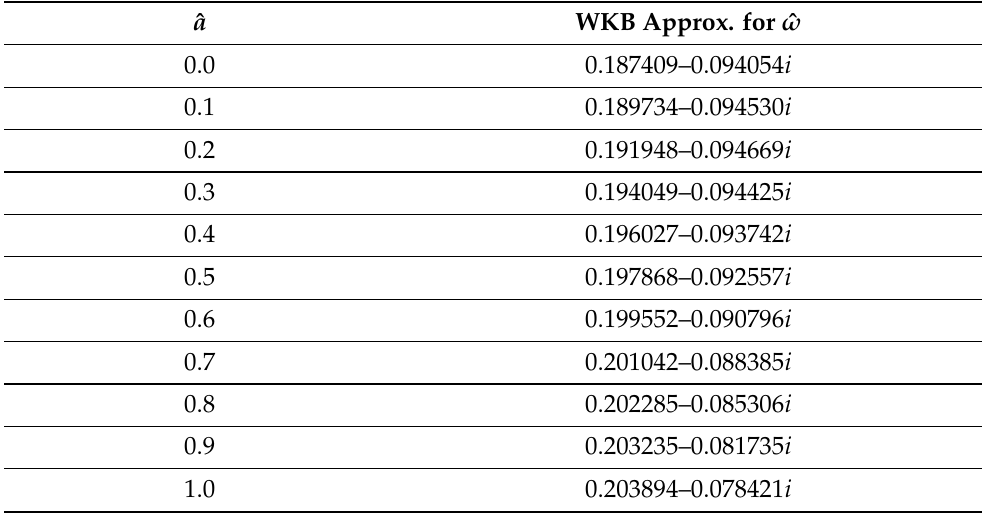
Table 2. Fundamental QNM of the massless, minimally coupled spin zero scalar field for the s -wave ( (cid:96) = 0), obtained via first-order WKB